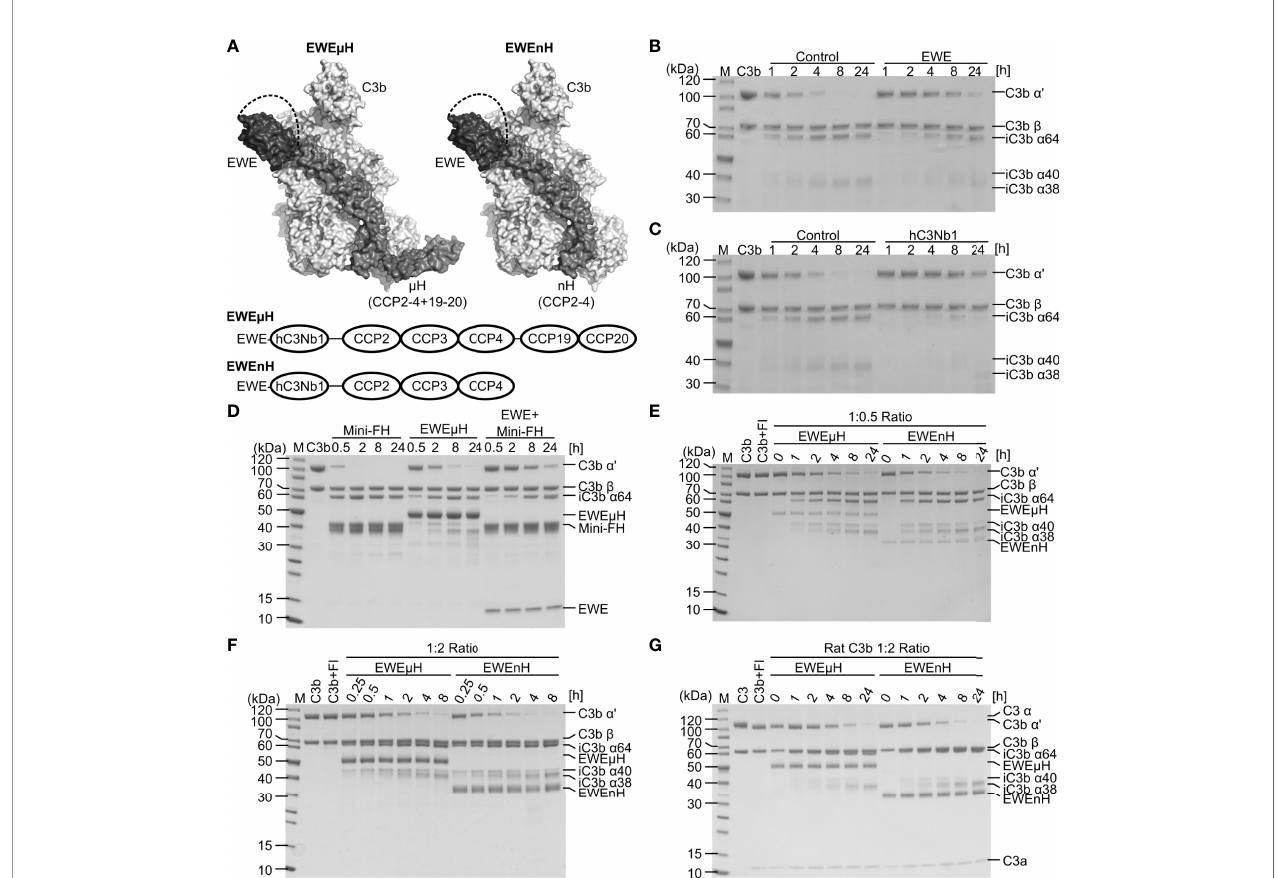
FIGURE 3 | Design and characterization of EWEµH and EWEnH. (A) Model of the EWEµH and EWEnH fusion proteins. The crystal structure of hC3Nb1 [PDB entry 6EHG] was superimposed onto the structure of C3b:mini-FH [PDB entry 5O35]. The dashed line illustrates a linker joining the C-terminus of the EWE moiety and CCP2. The lower panel illustrates the domain structure of EWEµH and EWEnH. (B, C) Effect of EWE and hC3Nb1 on C3b cleavage. C3b was incubated with FH, FI as well as a 1.2-fold molar excess of either (B) EWE or (C) hC3Nb1 and the cleavage was monitored by SDS PAGE. (D) EWEµH cleavage assay. C3b was incubated with a two-fold molar excess of mini-FH, EWEµH or mini-FH as well as EWE in the presence of FI. The cleavage of C3b was monitored by SDS-PAGE analysis upon the indicated incubation at 37°C. (E, F) Comparison of EWEµH and EWEnH. C3b was incubated with FI and EWEµH or EWEnH in molar C3b:EWEµH/ EWEnH ratios of (E) 1:0.5 and (F) 1:2. (G) Cleavage assay of rat C3b performed using a molar C3b:EWEµH/EWEnH ratio of 1:2. The C3b was generated from rat C3 using CVFBb and was immediately used for the cleavage assay, explaining the presence of C3a in the reactions. M , molecular weight